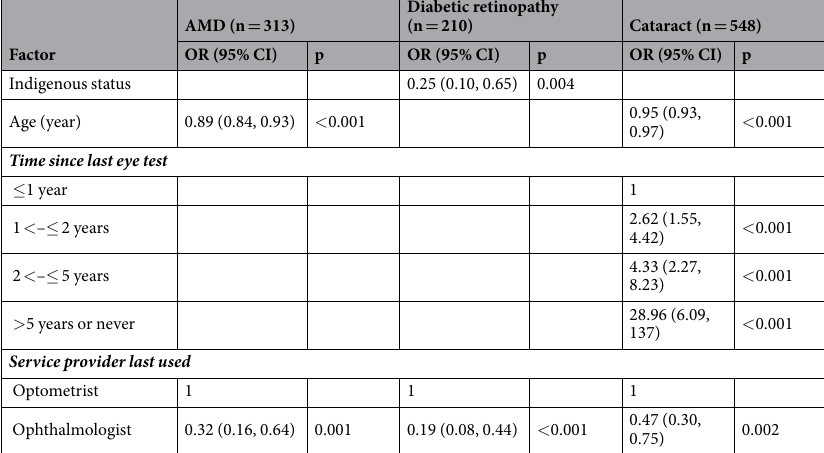
Table 3. Independent risk factors associated with unawareness of eye disease by cause. OR = Odds ratio. AMD = Age-related macular degeneration Only risk factors that were shown to have independent statistically significant associations (p < 0.05) in multivariable logistic regression analysis are shown. Other factors tested included; gender, years of education, English spoken at home, ethnicity of non-Indigenous Australians, and geographic